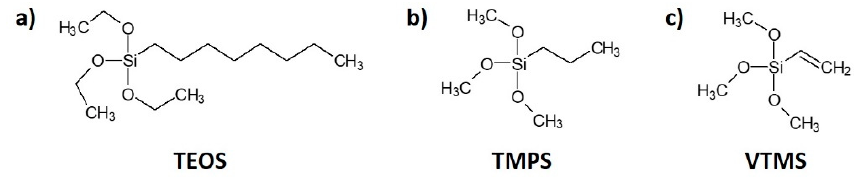
Figure 1. Chemical structure of silane coupling agents employed in this research: ( a ) triethoxyoctylsilane (TEOS); ( b ) trimethoxypropylsilane (TMPS); ( c ) vinyltrimethoxysilane (VTMS).